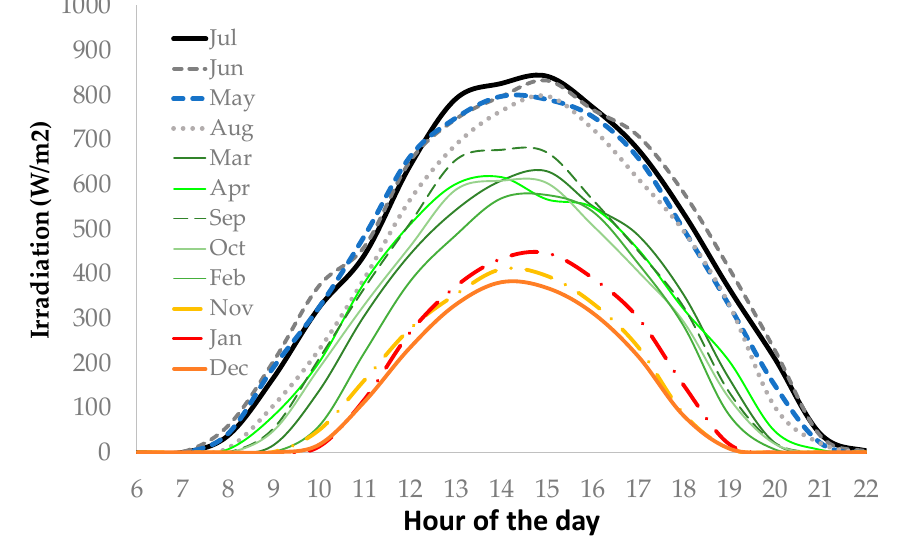
Figure 4. Monthly average irradiation (W/m 2 ).